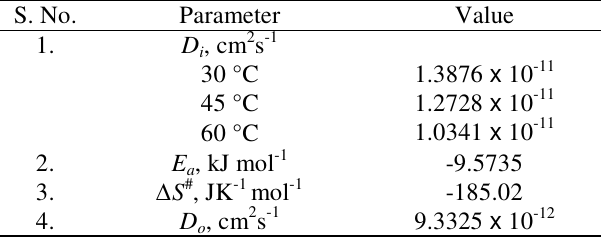
Table 4. Values of energy of activation E constant D for the present study o S.